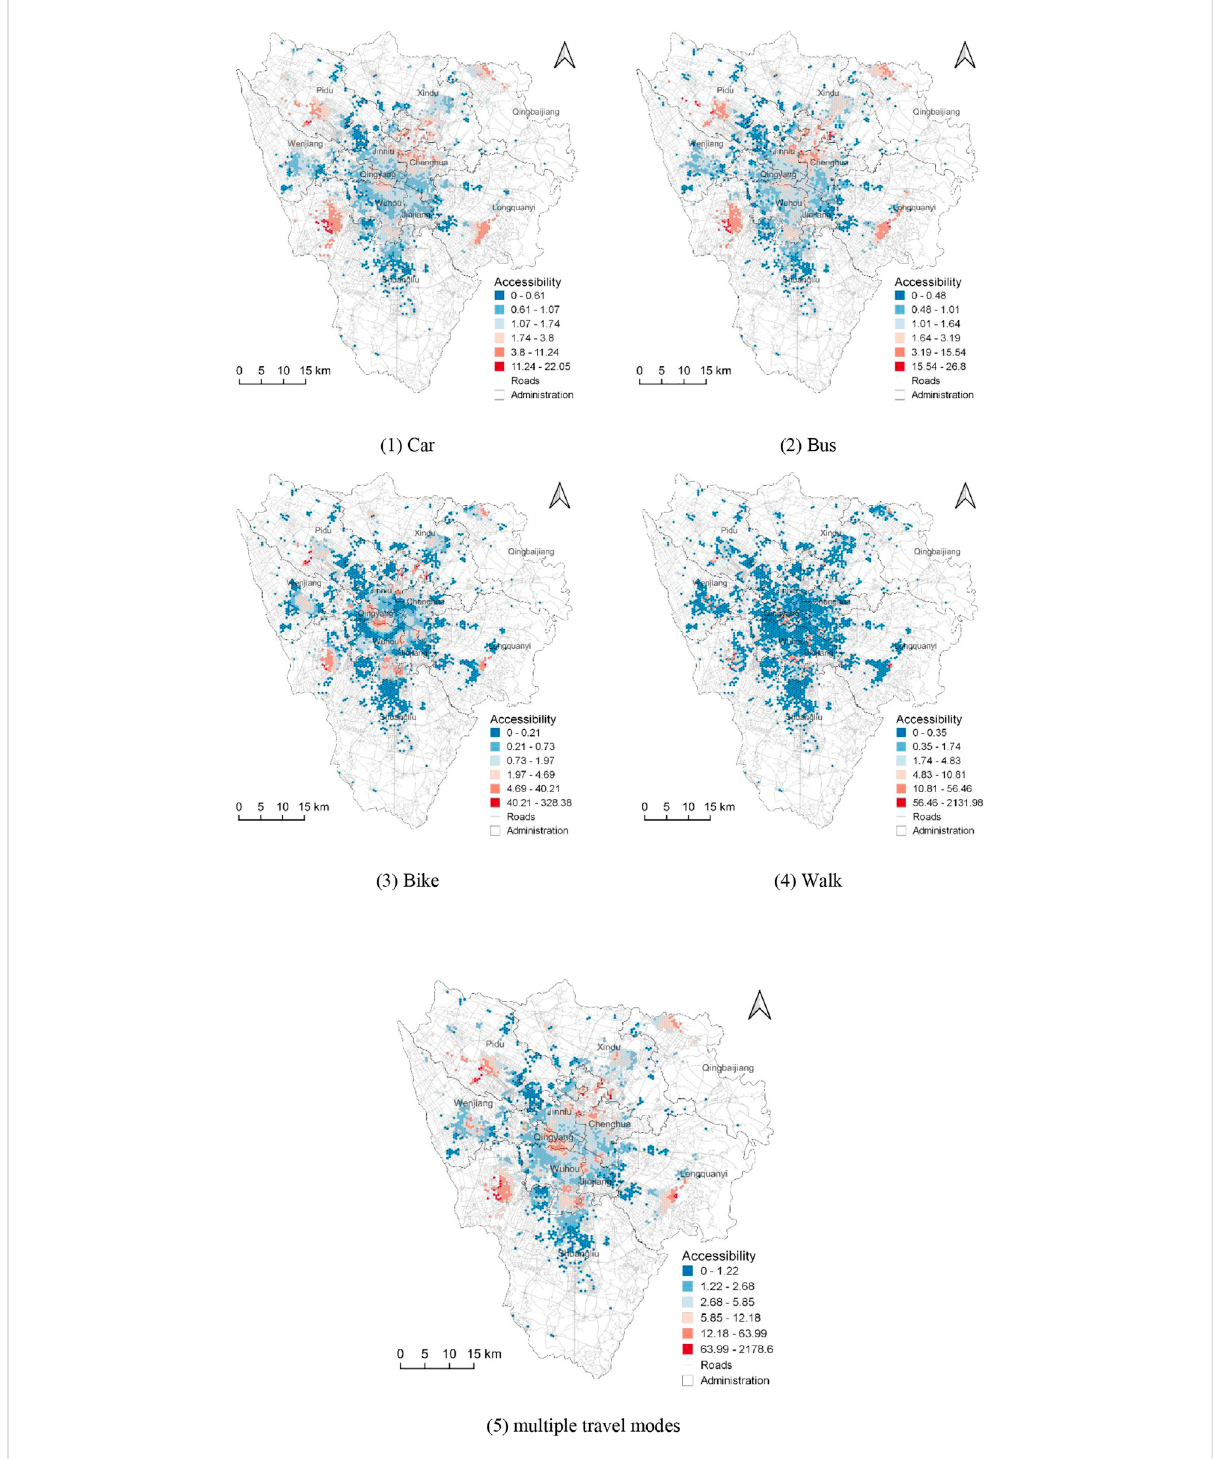
FIGURE 6 Park accessibility of four travel